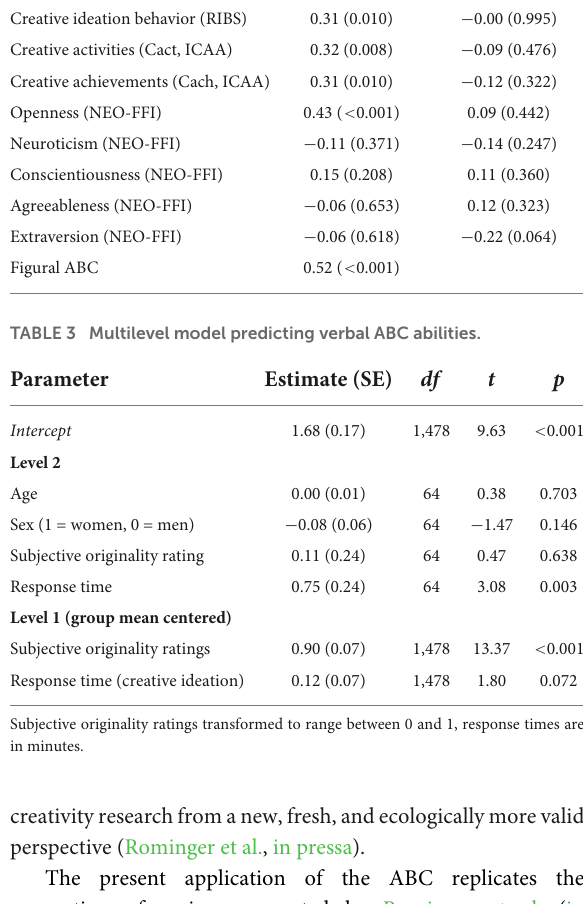
TABLE 2 Overview of Pearson correlations of between-person variables, separately for the verbal and the figural ABC.